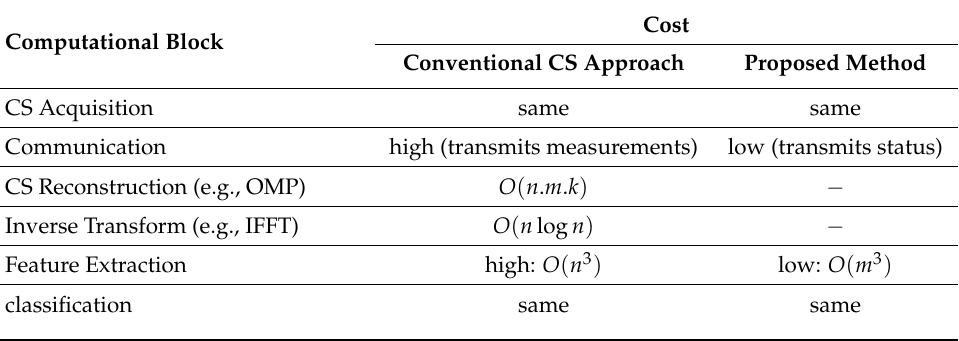
Table 4. Comparison of traditional compressed signal (CS) approach and proposed method based on computational